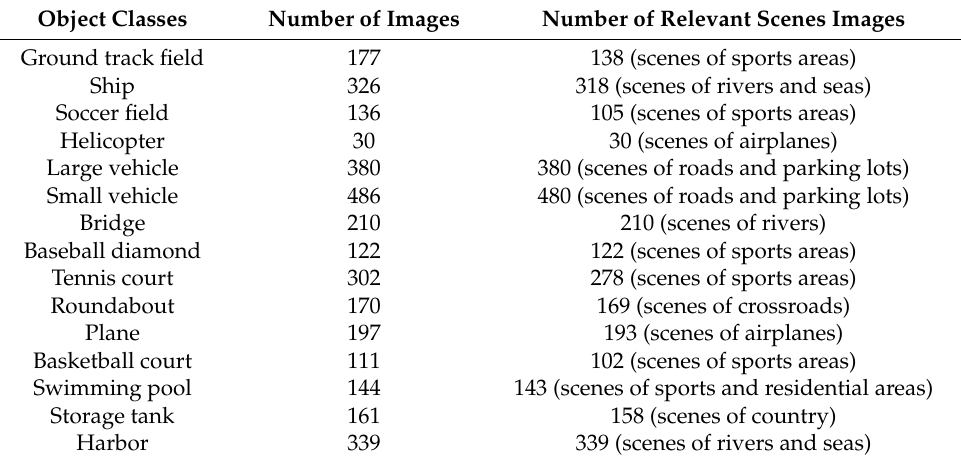
Table 1. Analysis results of the training part of the DOTA